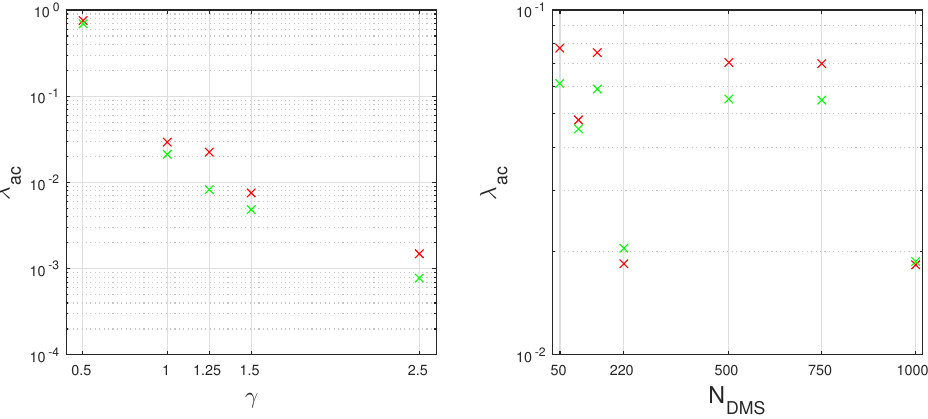
Figure 9. Values of λ ac at µ = 0.8 for horizontal planes (red) and vertical planes